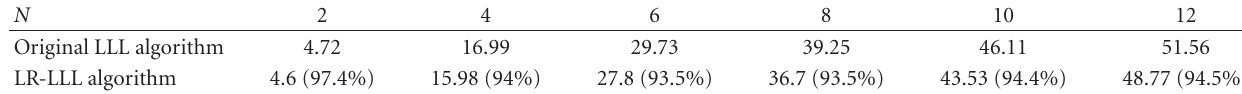
Table 2: Average loop of lattice-reduction Algorithms for di ff erent antenna